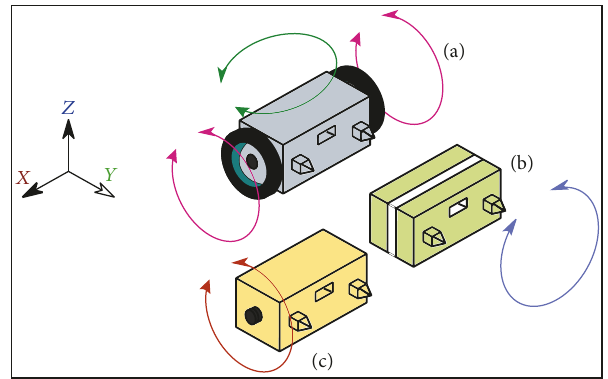
Figure 6: Structure of cells in CEBOT MSRR: (a) wheel mobile cell, (b) rotation joint cell, and (c) bending joint